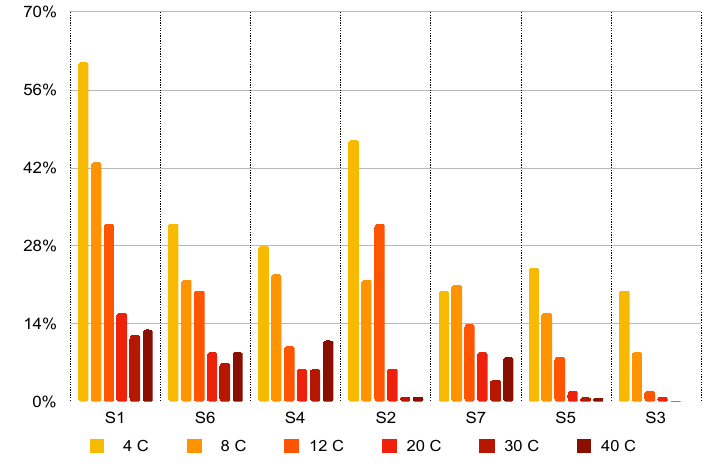
Figure 4. Total savings graph by